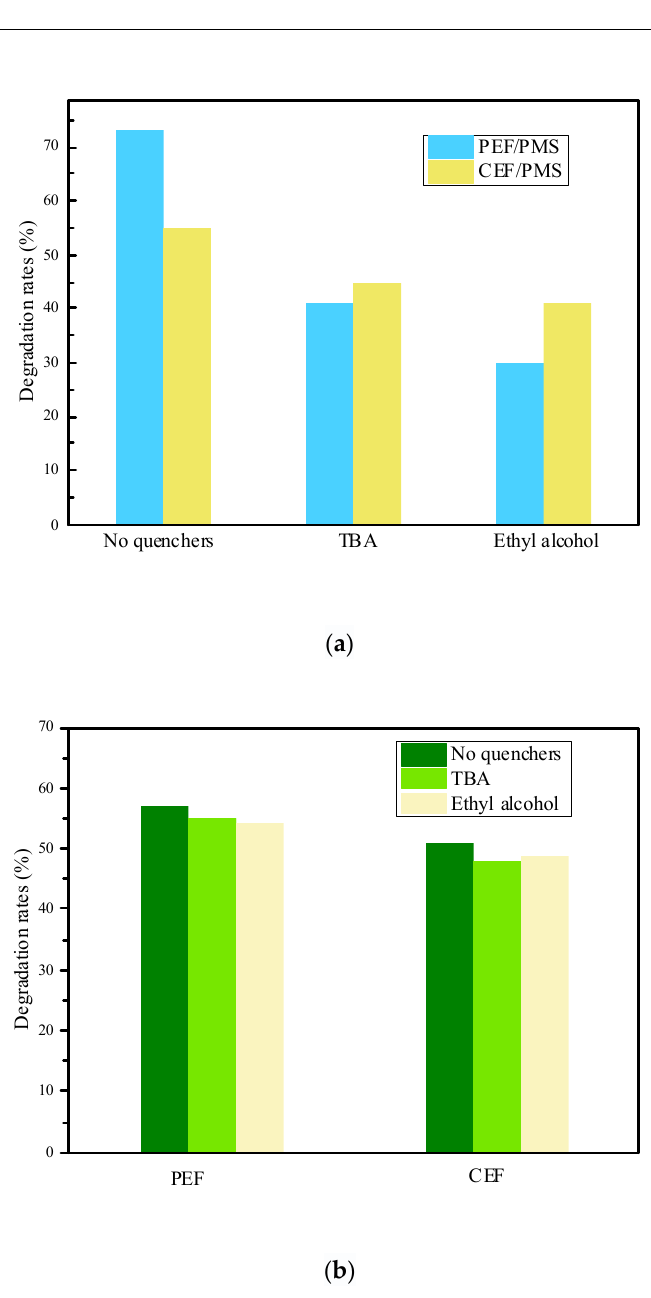
Figure 4. E ff ect of free radical inhibitors on SND degradation in the system. ( a ) E ff ect of free radical Figure 4. Effect of free radical inhibitors on SND degradation in the system. ( a ) Effect of free radical inhibitors on SND degradation in di ff erent electro-activated PMS systems; ( b ) E ff ect of free radical inhibitors on SND degradation in different electro-activated PMS systems; ( b ) Effect of free radical inhibitors on SND degradation in the di ff erent electric fi eld system. Concentrations of quenchers inhibitors on SND degradation in the different electric field system. Concentrations of quenchers were 0.5 mol/L. were 0.5